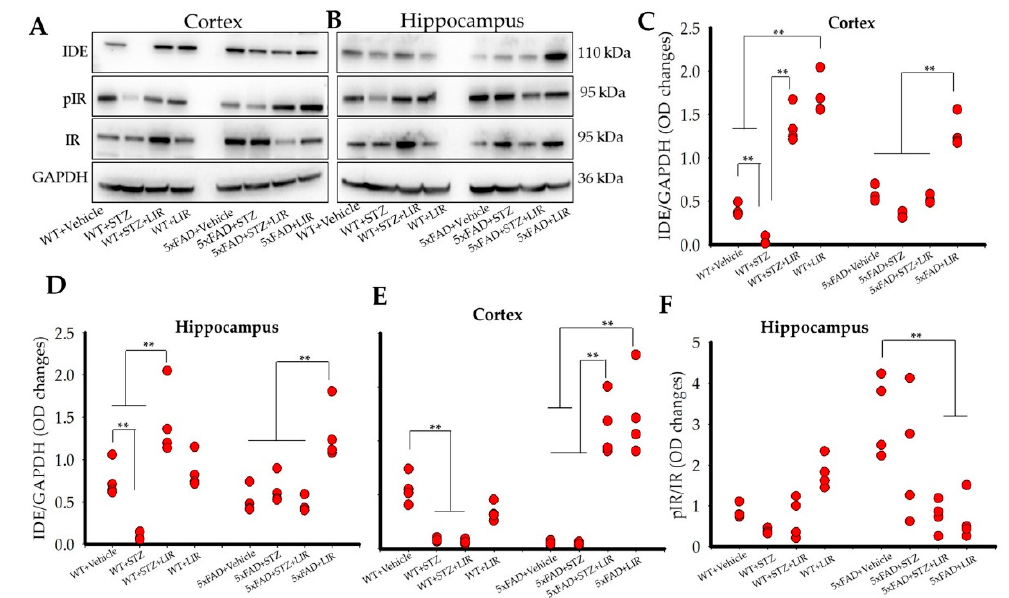
Figure 5. Insulin-Degrading Enzyme and Phosphorylated Insulin Receptor protein levels in the cortical and hippocampal regions of the WT and 5xFAD mice. Following LIR treatment, WT and 5xFAD mice ( n = 3 from each group) were sacrificed via cervical dislocation and their brains were immediately collected and homogenized for Western blot analysis. ( A , B ): Representative Western blot bands for IDE, pIR, and IR in both cortical and hippocampal regions of WT and 5xFAD mice. ( C , D ): Histograms showing densitometric quantification of IDE, normalized with GAPDH, in the cortex and hippocampal regions of the brain, respectively. ( E , F ): Histograms showing densitometric quantification of pIR normalized with GAPDH and IR in the cortex and hippocampal regions of the brain, respectively. ** p < 0.01.